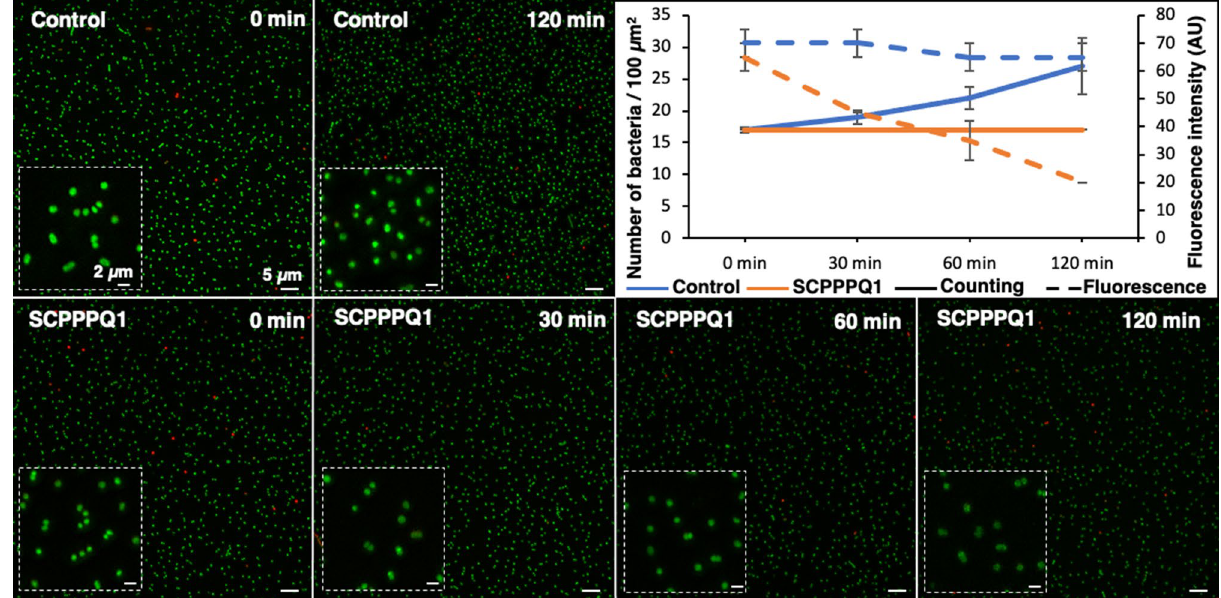
Figure 2. Super-resolution live-and-dead fluorescence imaging of P . gingivalis incubated with buffer only (control) and SCPPPQ1 (20 µM) . Both qualitative visual evaluation (insets) and quantitative evaluation of the fluorescence (also see Fig. S3), show that there are no significant changes in fluorescence intensity throughout the incubation interval for the control, while there is a major drop when cells are incubated with SCPPPQ1. Quantification of the bacteria (upper right panel) shows that between the 0 and 120 min interval the number of bacteria almost doubles whereas with SCPPPQ1 it remains static. In all cases, very few dead cells (red) are evident. Green = Syto9 labelling; Red = Propidium iodide. Data represent the means ± SD (n =